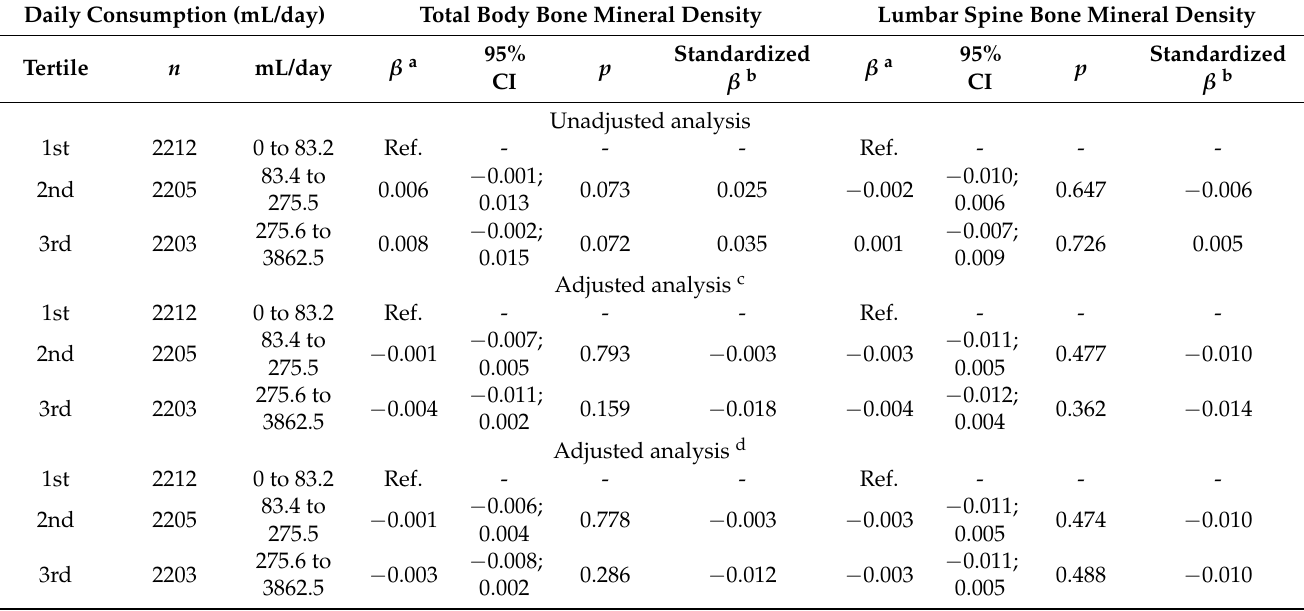
Table 4. Association between the daily consumption of sugar-sweetened beverages and bone mineral density in young people of the RPS Brazilian Birth Cohorts Consortium (Ribeir ã o Preto, Pelotas, and